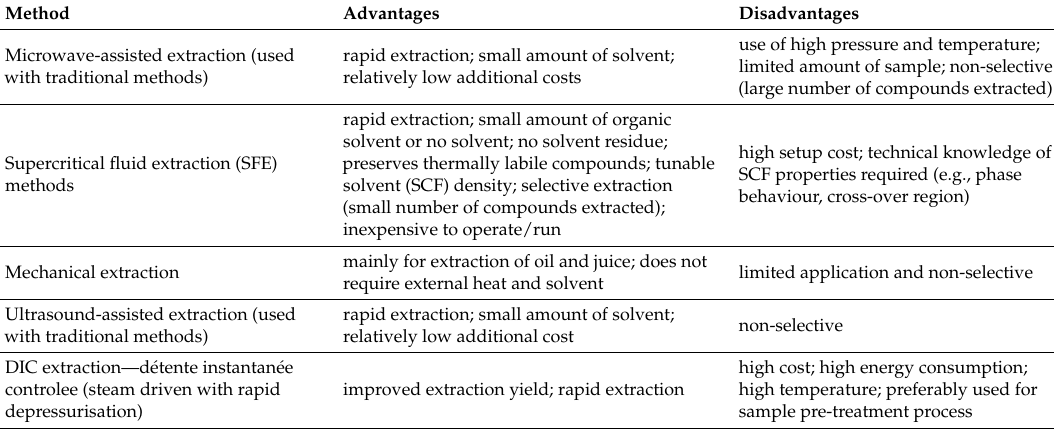
Table 1. The advantages and disadvantages of greener extraction